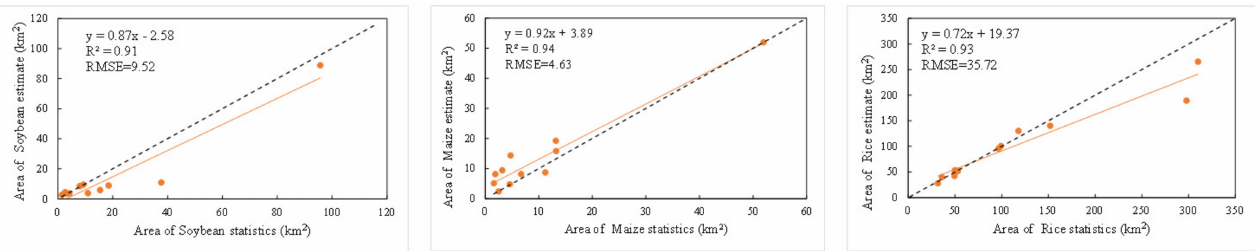
Figure 11. Correlation of the model − estimated main crop area with the statistical area in 2019.